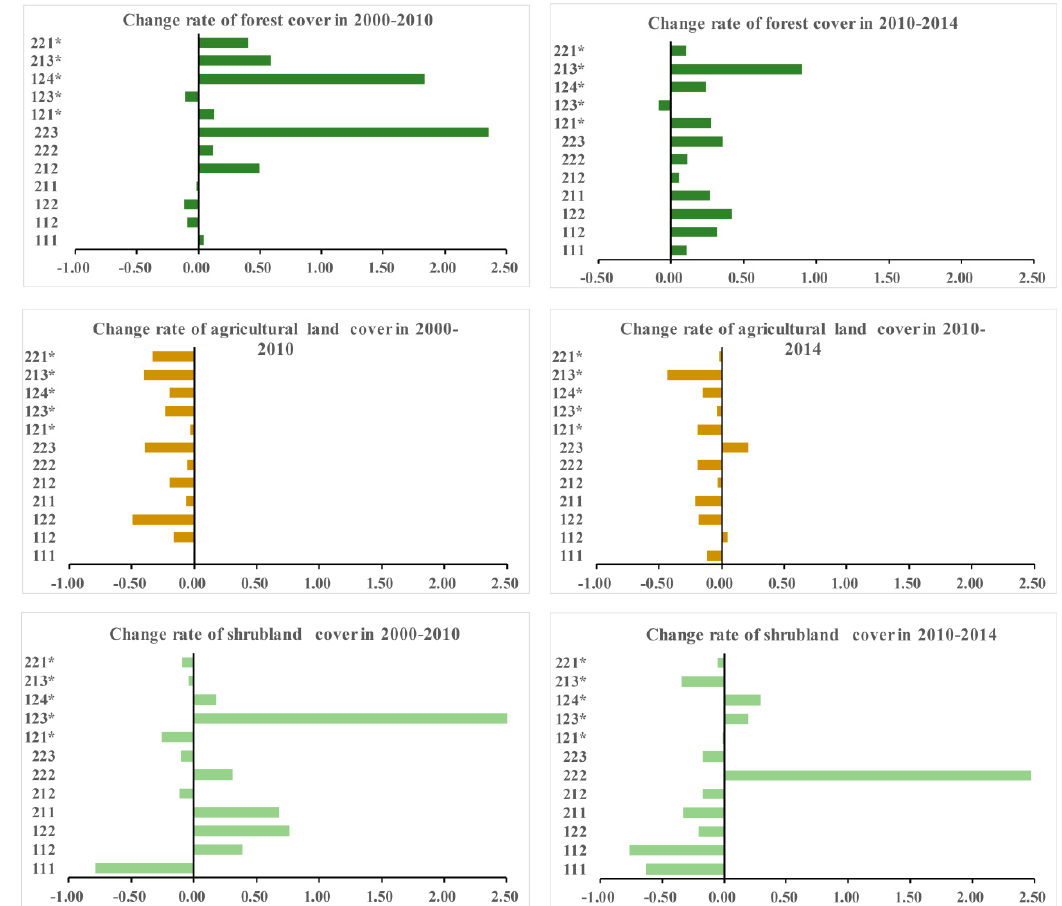
Figure 3. Change rate of forest, shrubs and agricultural land cover for each community in 2000–2010 and 2010–2014. * indicates communities that implemented RFFP.